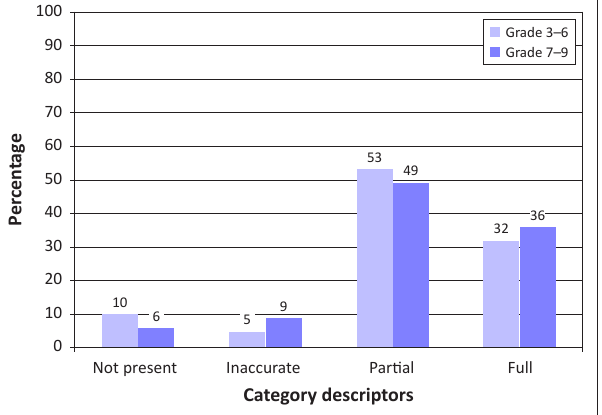
FIGURE 2: Procedural explanations of learners’ correct answers by grade groups.